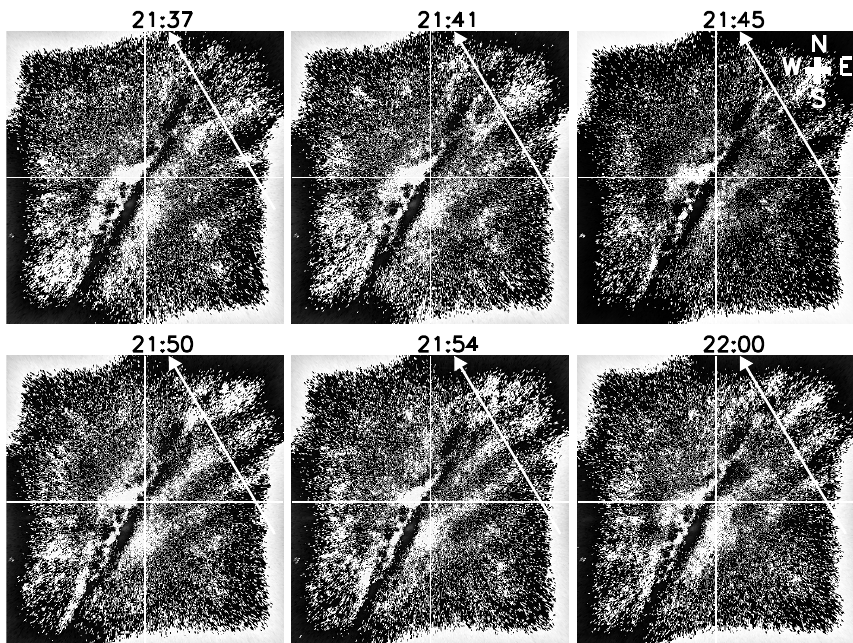
Figure 1. Sequence of unwarped images showing a gravity wave propagating to the northwest (north is to the top and east is to the right) observed on 20 September 2006. Universal time is shown at the top of the images. Darkened grooves in the center of the images represent the Milky Way. White arrows are pointed in the propagation direction of the wave. (See the movie in the Supplement for further details about the propagation of this periodic wave and the filtering process,